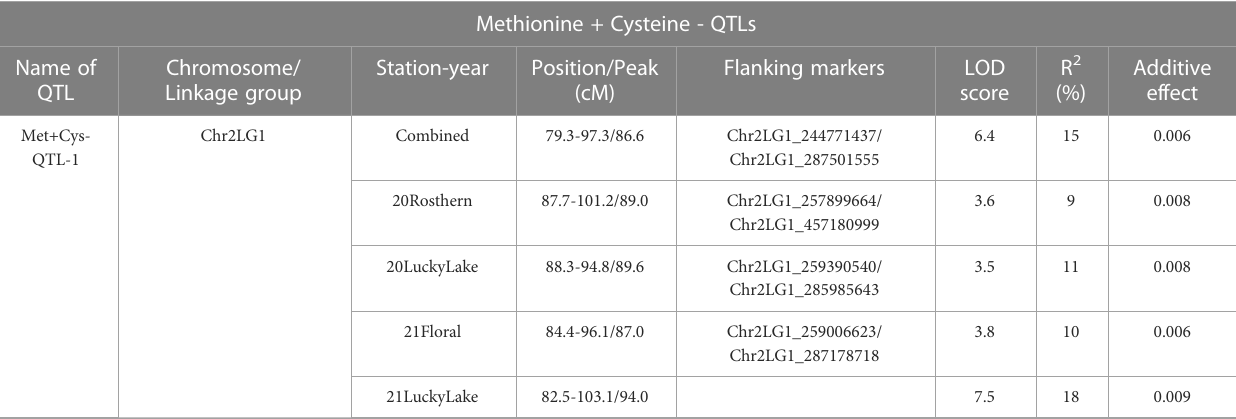
TABLE 5 Detected quantitative trait loci (QTL) for methionine + cysteine, tryptophan, lysine concentration, and in vitro protein digestibility in PR-25 using composite interval mapping